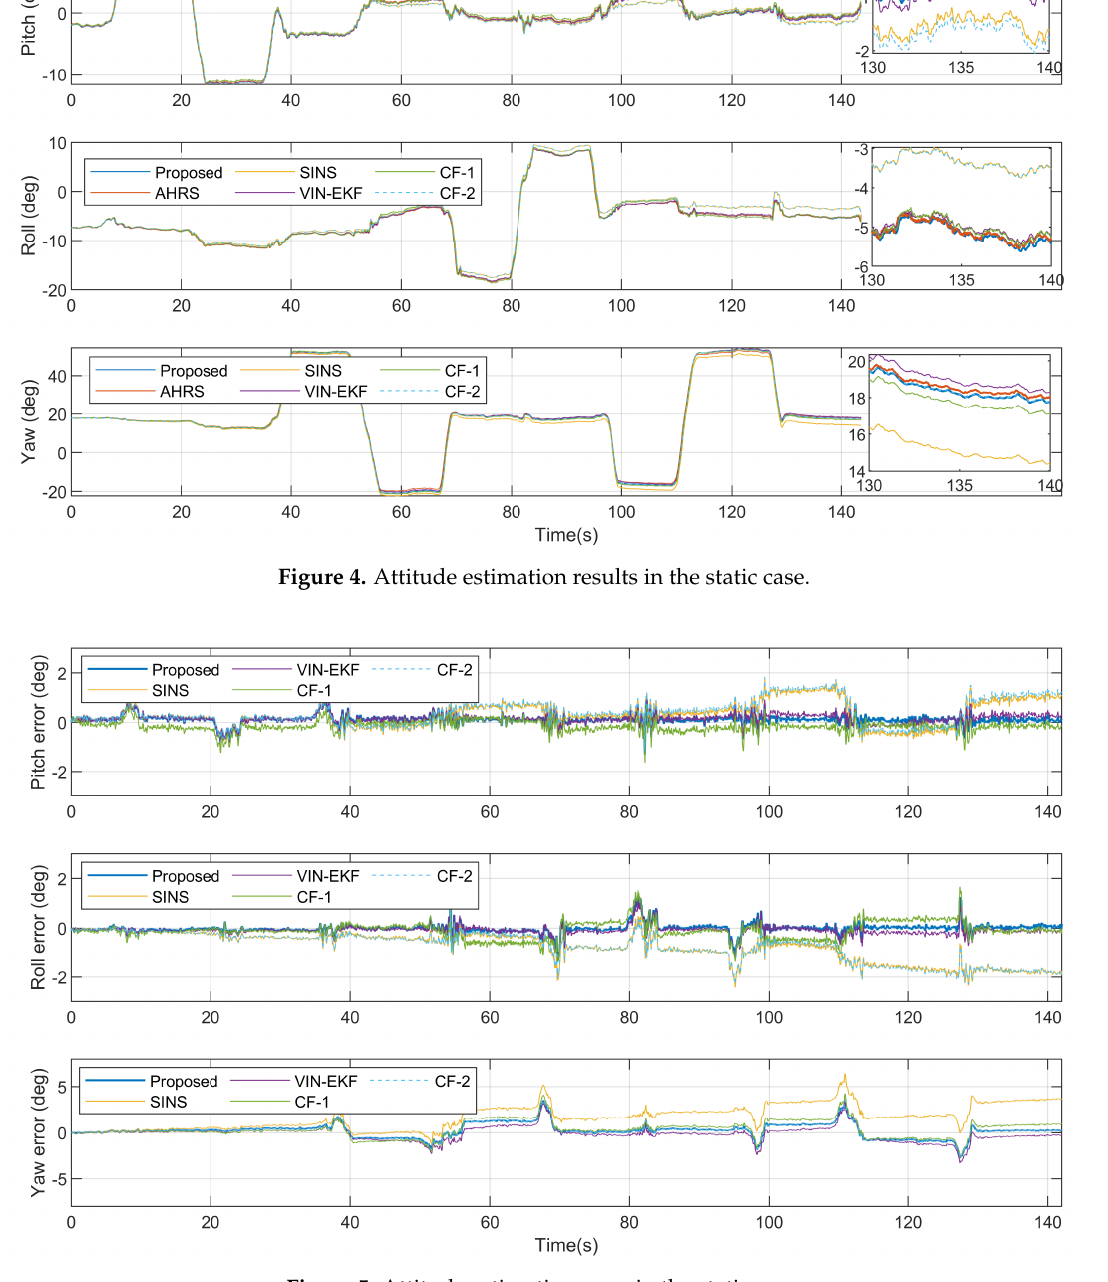
Figure 5. Attitude estimation error in the static case. Table 1. RMSE of attitude angles in the static